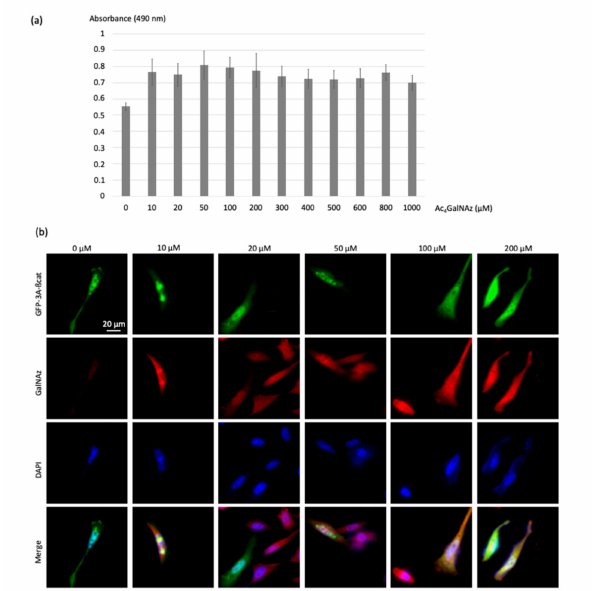
Figure 4. Optimization of the concentration of the chemical reporter. ( a ) The histogram represents the cytotoxicity evaluation of the chemical reporter Ac 4 GalNAz; Hela cells were treated at a concentration of 0 to 1000 µ M. Twenty-four hours later, the cell viability was determined using the MTS assay. ( b ) HeLa cells transfected with the GFP-3a- β -catenin expressing vectors were treated with increasing Ac 4 GalNAz concentration (10, 20, 50, 100, and 200 µ M) and labeled with DBCO-cy3 (10 µ M). The azidosugar was then labeled with the DBCO-cy3 FRET acceptor (10 µ M) using the SPAAC reaction, permitting visualization of O -GlcNAz-modified β -catenin. Colocalization of green and red signals produced a yellow color, validating the dual-labeling (Figure